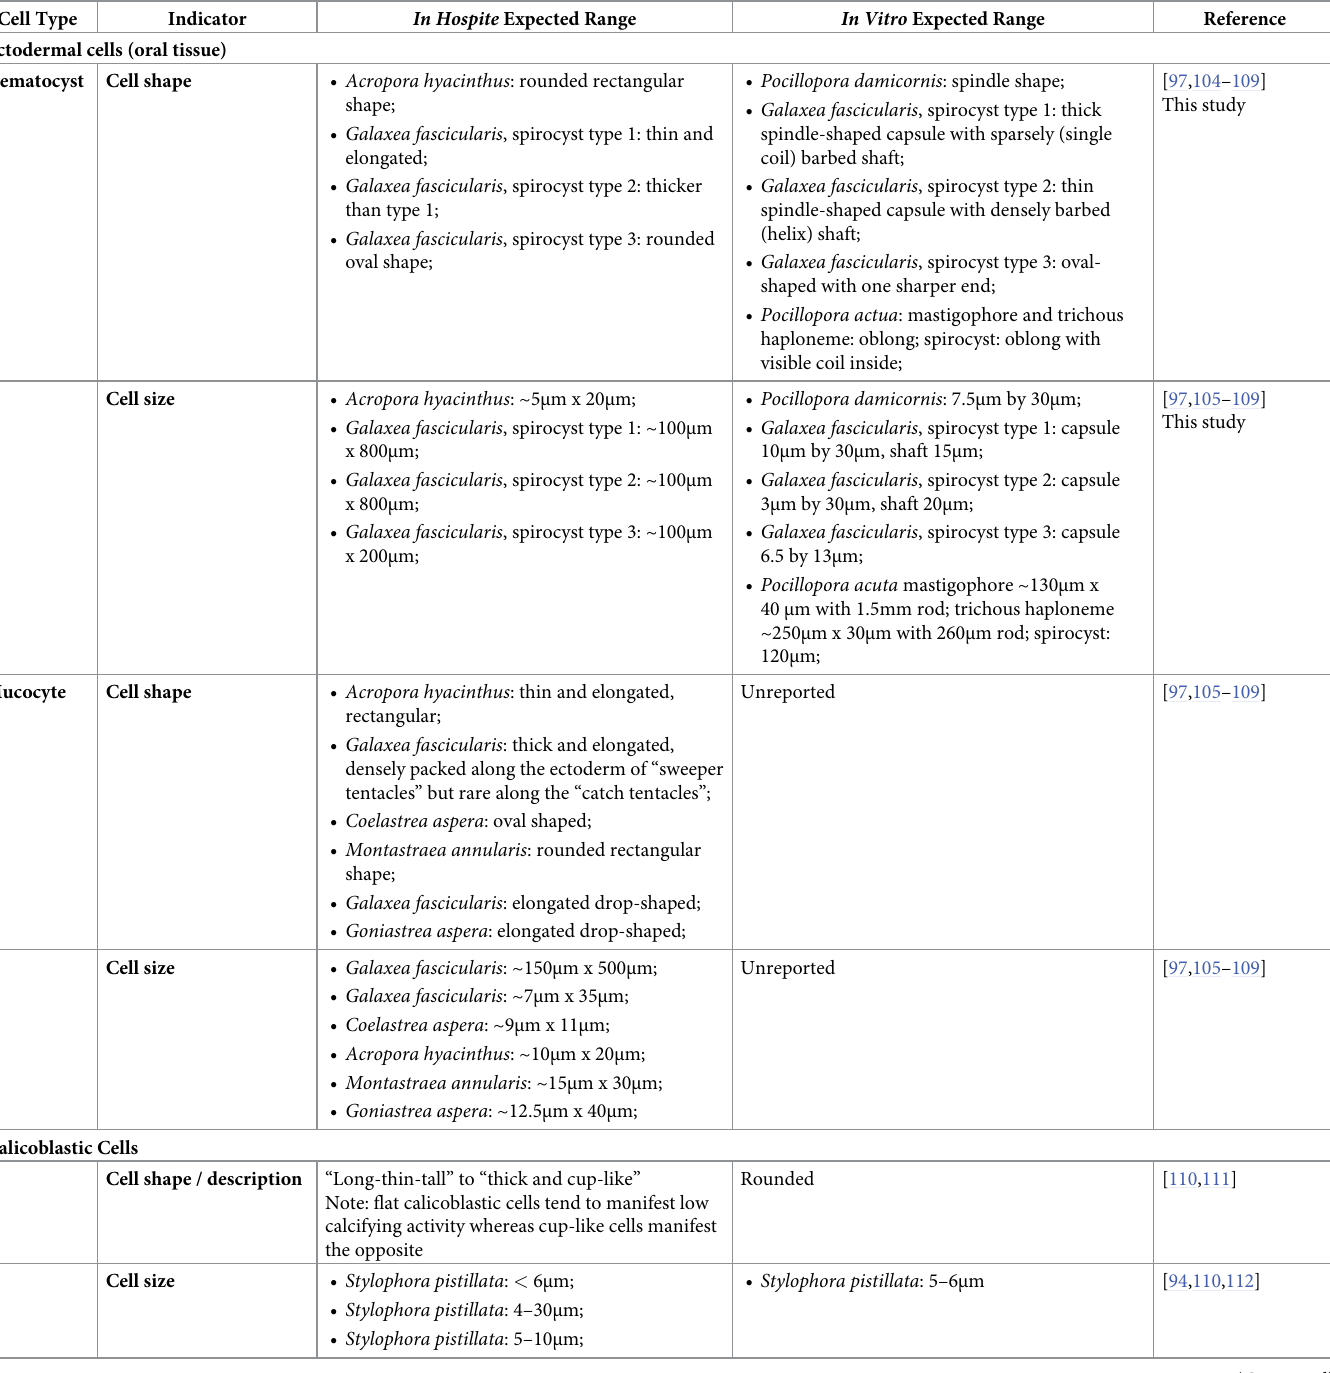
Table 1. Benchmark measurements according to cell type, in hospite and in vitro for coral cell line